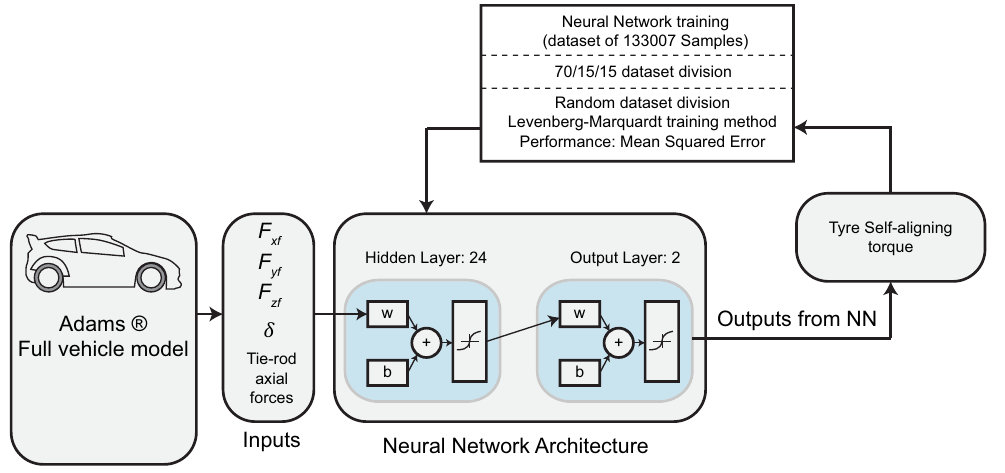
Figure 19. Estimation structure described in Luque et al. [9]. Figure adapted by the authors from